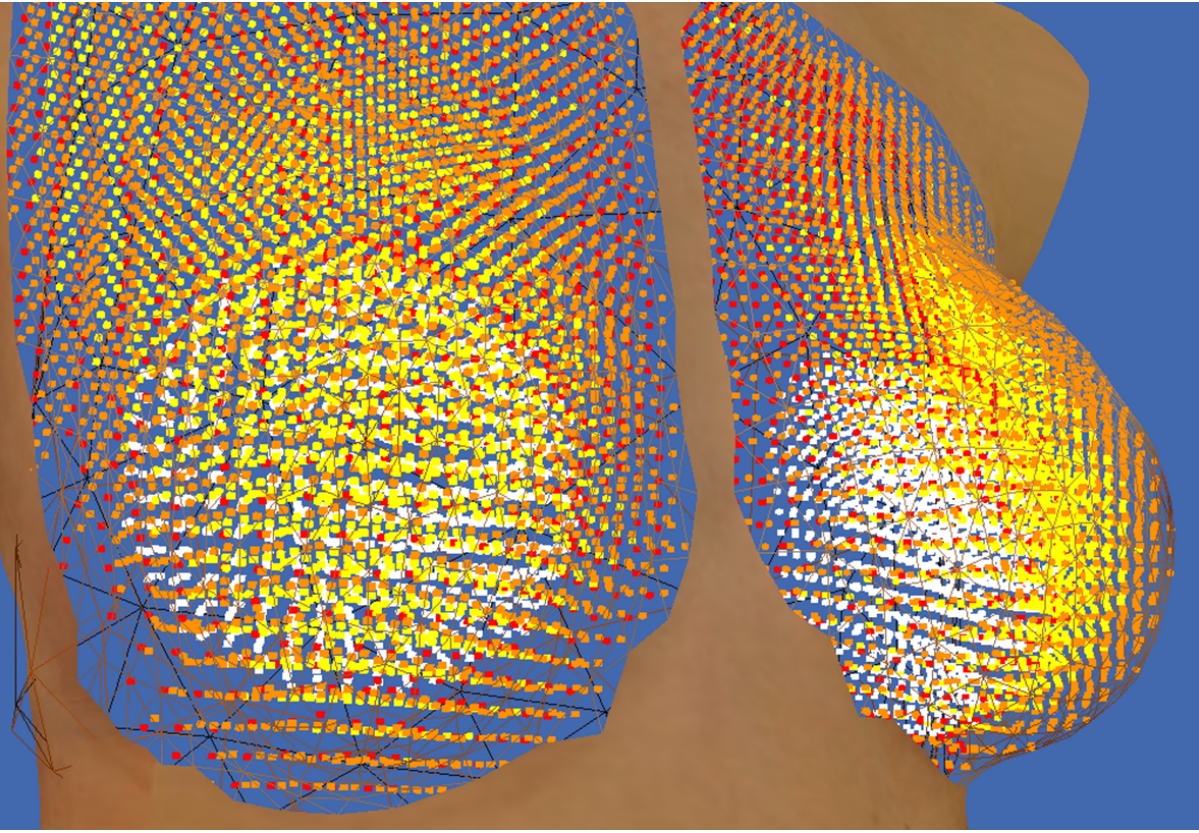
Figure 5. Voxelized breasts and implants. The fat layer is seen in yellow, the skin in orange, and the muscle layer in red. The implants are shown as white voxels or particles. This screenshot is taken from the simulation developer’s point of view and is not visible in the Web-based